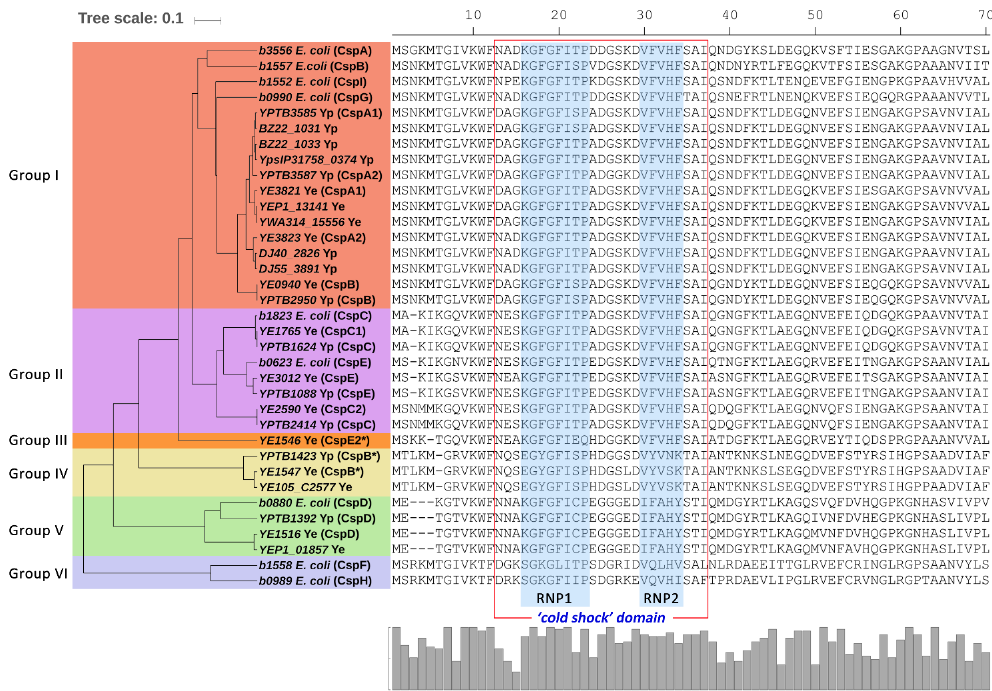
Figure 3. Phylogenetic group of representative Csps in Escherichia coli and enteropathogenic Yersinia . A phylogenetic tree and alignment of representative Csps in E. coli and enteropathogenic Yersinia. The phylogenetic groups of representative Csps were represented by color. Conserved RNP motifs of Csps were colored light blue. Most Csps were named using the convention of E. coli , if any, except those marked with an asterisk. The alignment is trimmed to the 70th site for better viewing. Histogram shows Csp sequence